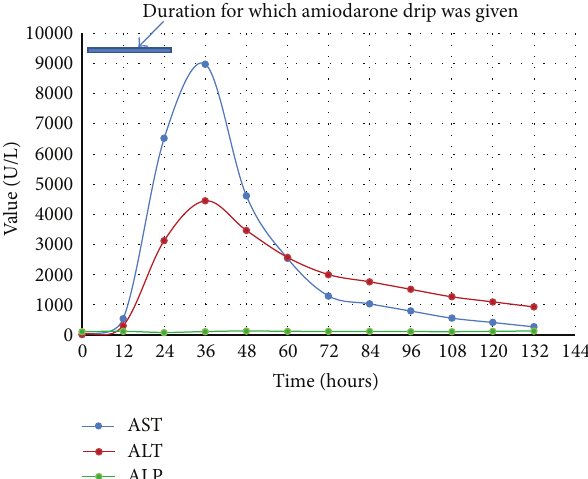
Figure 1: Elevation of liver enzymes after IV amiodarone.